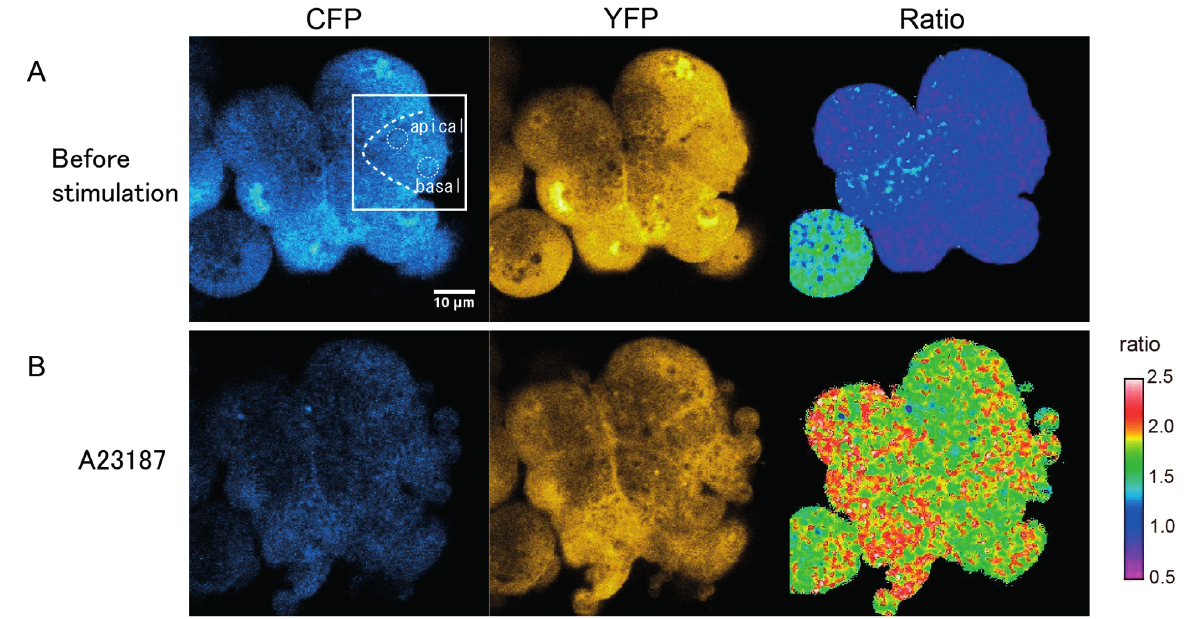
Figure 2. Dynamic range of the fluorescence ratio of cyan and yellow fluorescent proteins (CFP and YFP) (Förster resonance energy transfer ratio, FRET ratio) in pancreas acinar cells of YC-Nano15-205 mice. ( A , B ) Change in FRET signal following ionophore application. Two-photon excited fluorescence images of CFP and YFP, and fluorescence resonance energy transfer (FRET) ratio (YFP/CFP) image (right) before ( A , − 57 s) and after ( B , 1557 s) stimulation with Ca 2+ /A23187 solution are shown; these timings are also indicated as small bars at the top of ( C ). In both ( A ) and ( B ), the FRET ratio is distributed homogenously in the cell; ( C , D ) Time course of CFP and YFP signals and FRET ratio in the “apical” and “basal” circles in the cell shown inside withe box in ( A ). After stimulation with a minimum concentration of 5 nM acetylcholine (ACh), the FRET ratio increased slightly; ( E , F ) Detailed view of FRET signal changes upon stimulation of 5 nM ACh in the same experimental trial shown in ( A – D ). Timings of the images in ( E ) correspond to the small bars at the top of ( F ). Unidirectional propagation of the [Ca 2+ ] increase from the apical to the basal region of the cell is shown in ( E ); and ( G ) Time course of changes in the FRET ratio in the apical and basal regions of the cell shown in ( A